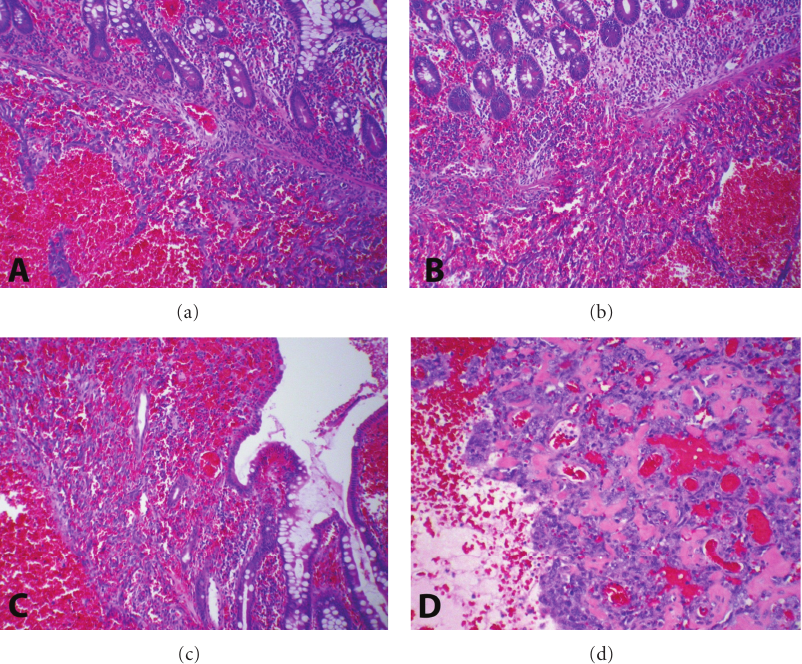
Figure 3: (a) Tumor underneath muscularis mucosa of small bowel; (b) edge of tumor with disruption of muscularis mucosa; (c) tumor extending into mucosa at edge of tumor (see macroscopic image Figure 1); (d) portion of tumor showing retiform “hemangioepithelioma.”